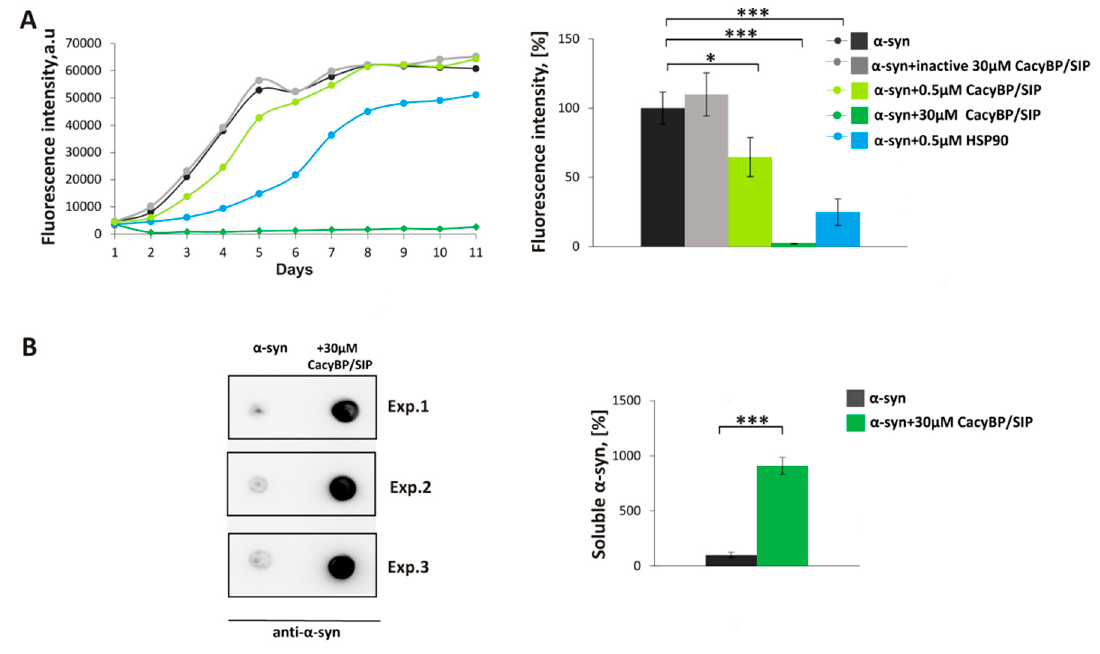
Figure 1. Influence of CacyBP/SIP on α -synuclein aggregation. ( A, left panel ) Representative curves showing ThT fluorescence of 30 µM α -synuclein alone (black) or in the presence of: 30 µM inactive CacyBP/SIP (grey), 0.5 µM CacyBP/SIP (light green), 30 µM CacyBP/SIP (green) or 0.5 µM HSP90 (blue). ( A, right panel ) Statistical analysis of the results for samples taken on day 4 of incubation ( n = 3). ( B, left panel ) Dot-blots showing α -synuclein immunostaining in the soluble fraction (supernatant) in samples taken on day 4 of α -synuclein aggregation, alone or in the presence of 30 µM CacyBP/SIP and ( B, right panel ) densitometric analysis of the results ( n = 3). Data, calculated as means ± SEM, are presented as percentage values. * p ≤ 0.05, *** p ≤ 0.001.